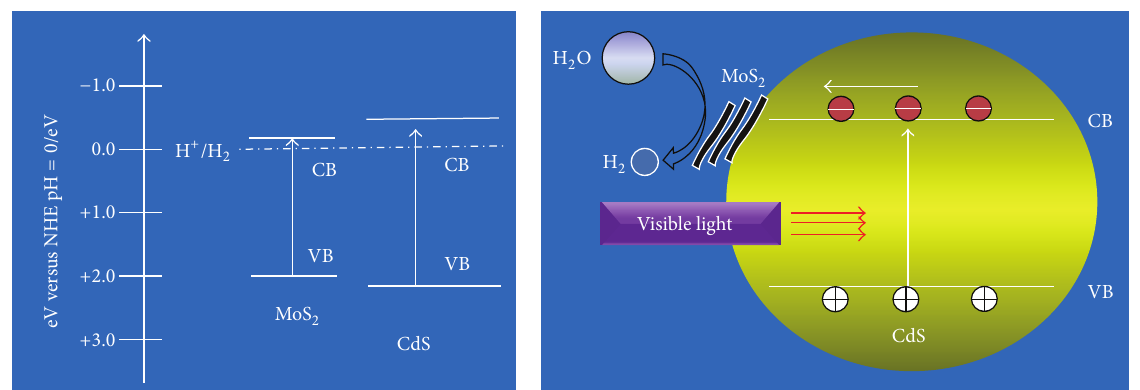
Figure 7: Schematic diagram of H 2 production mechanisms on MoS 2